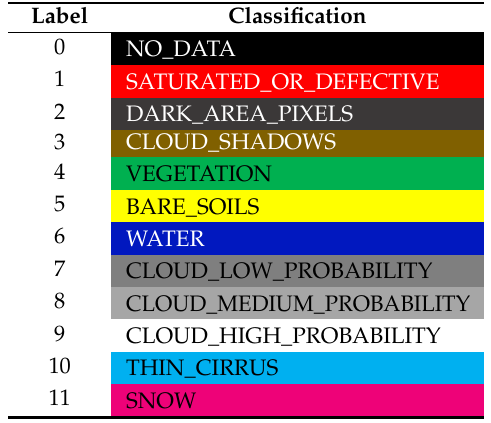
Table 1. Non-standard general-purpose, user- and application-independent European Space Agency (ESA) Earth observation (EO) Level 2 scene classification map (SCM) legend adopted by the sensor-specific Sentinel 2 (atmospheric, adjacency and topographic) Correction (Sen2Cor) Prototype Processor [11,12], developed and distributed free-of-cost by ESA to be run on the user side.